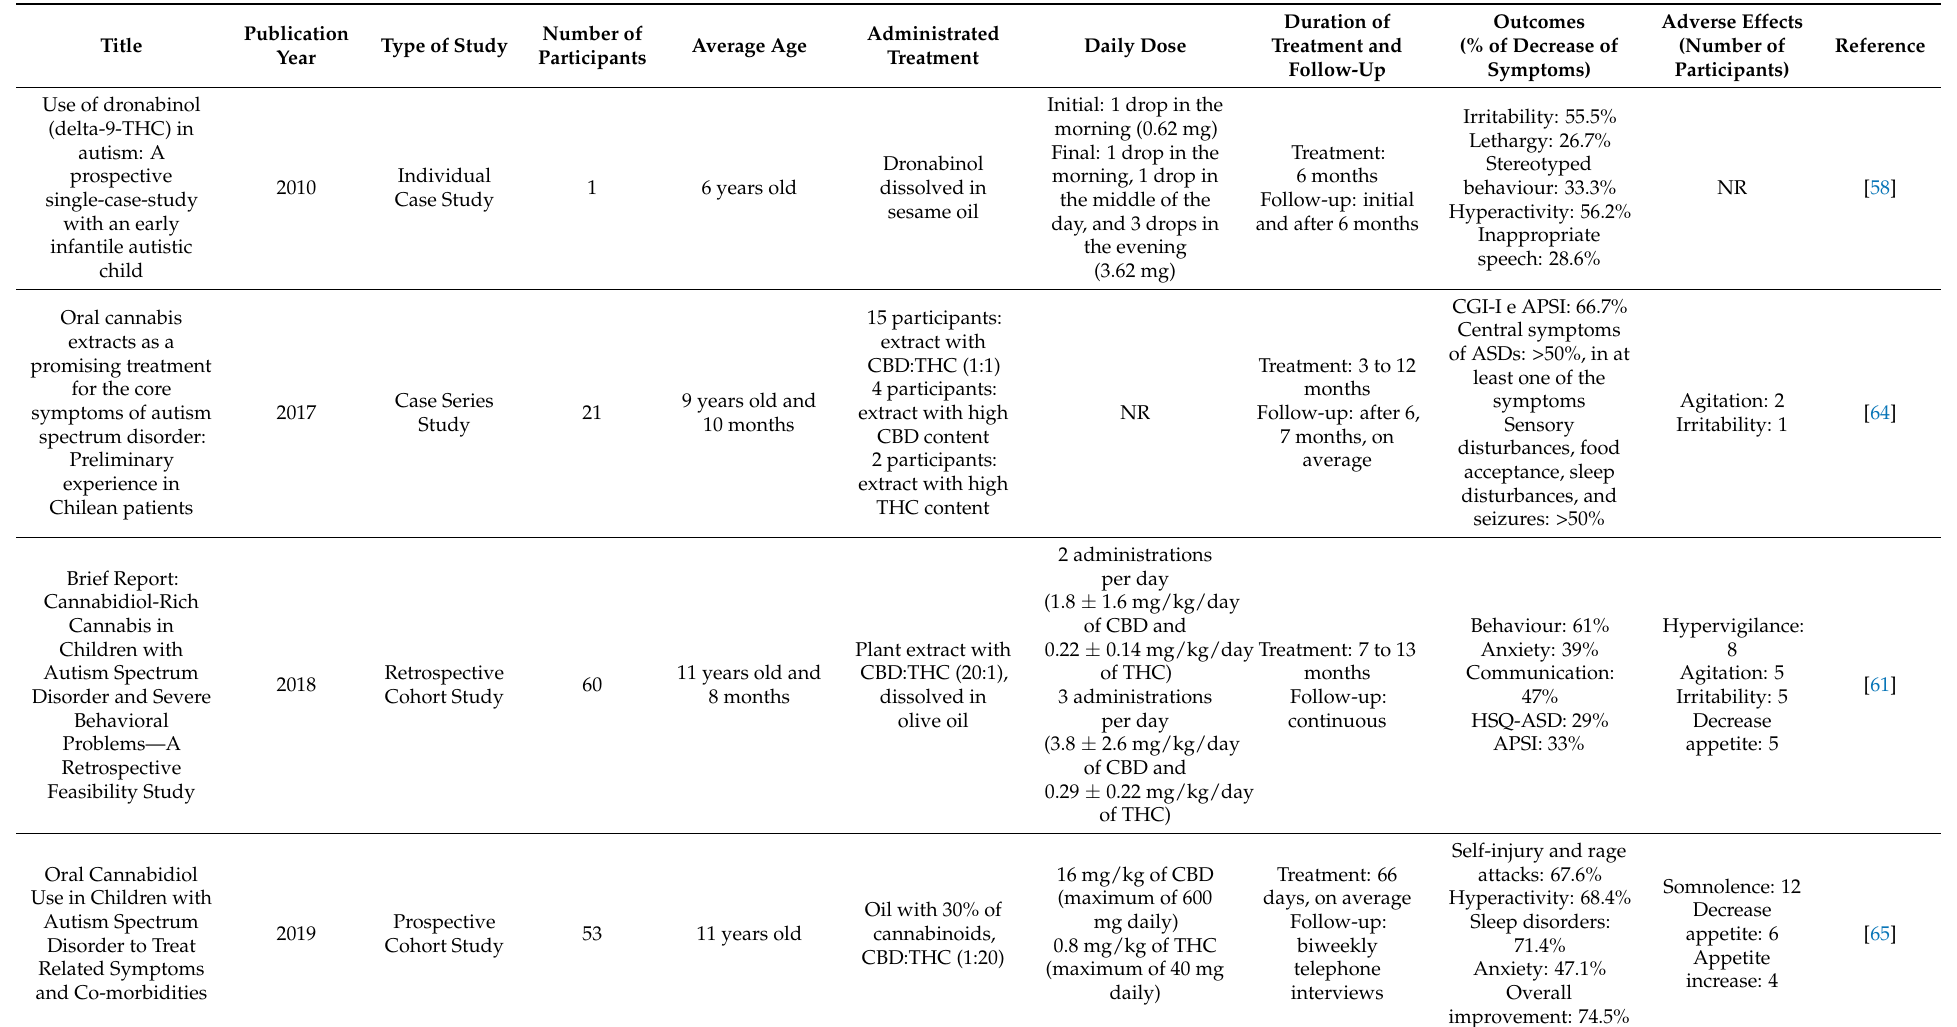
Table 2. Characteristics and results of preliminary studies with extracts of cannabis, cannabinoids, and their